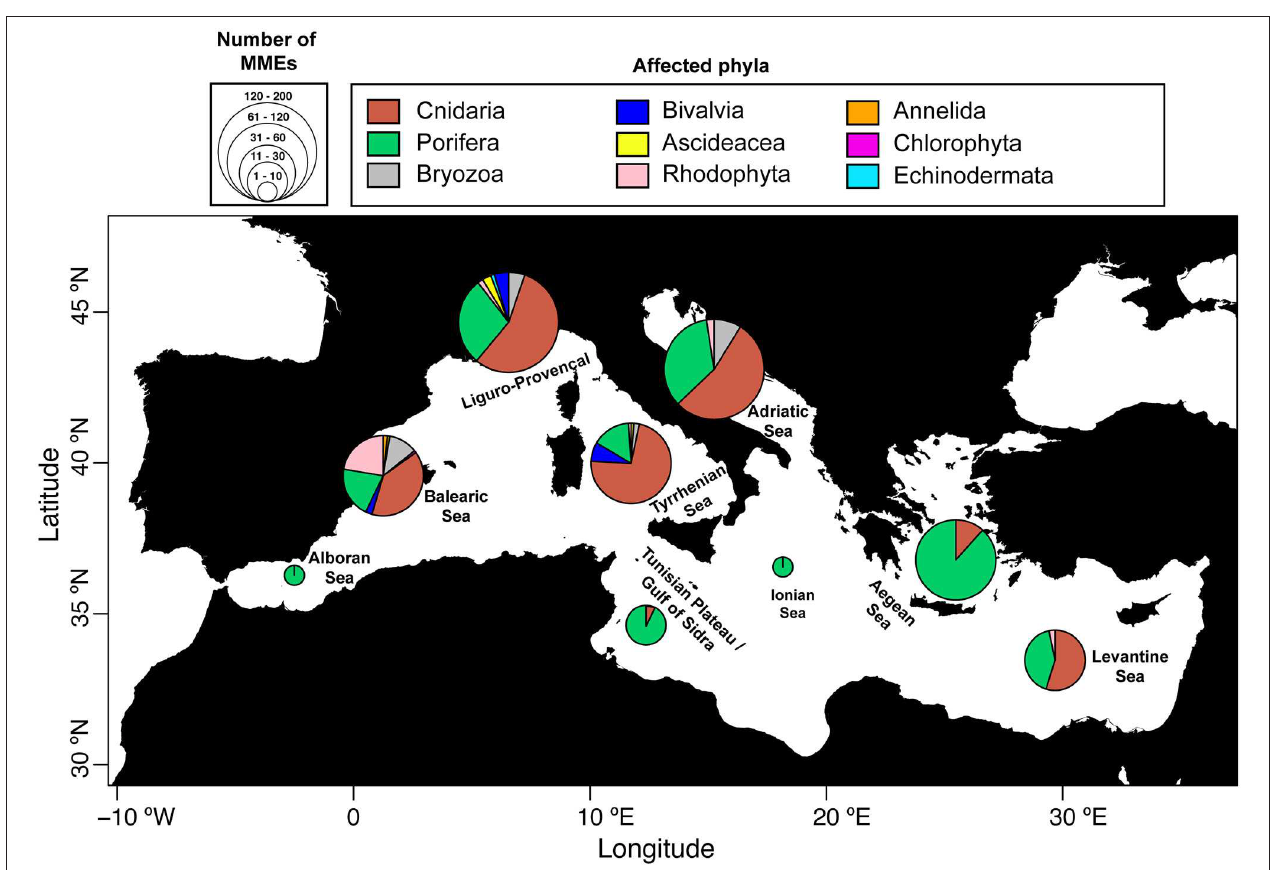
FIGURE 1 | Number of mass mortality events reported in the Mediterranean Sea: geographic distribution and taxa affected over the period from 1979 to 2017 (the Western Mediterranean ecoregion was further divided in three sub-ecoregions: Balearic Sea, Liguro-Provençal Sea and Tyrrhenian Sea).